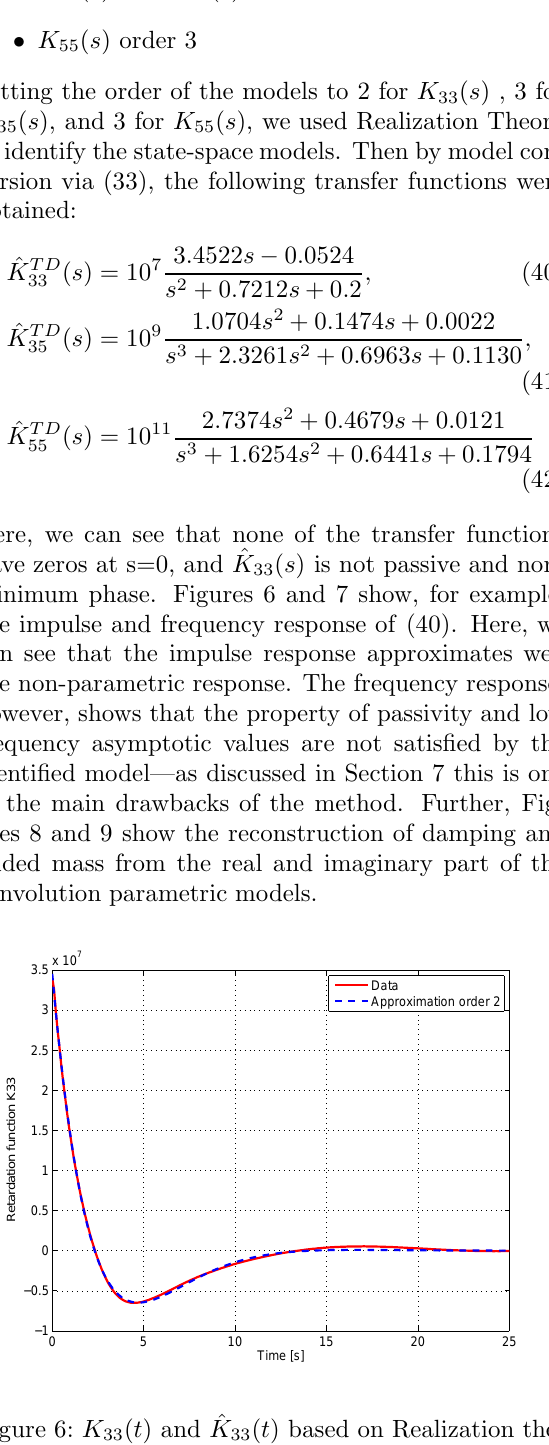
Figure 6: K 33 ( t ) and ˆ K 33 ( t ) based on Realization the-